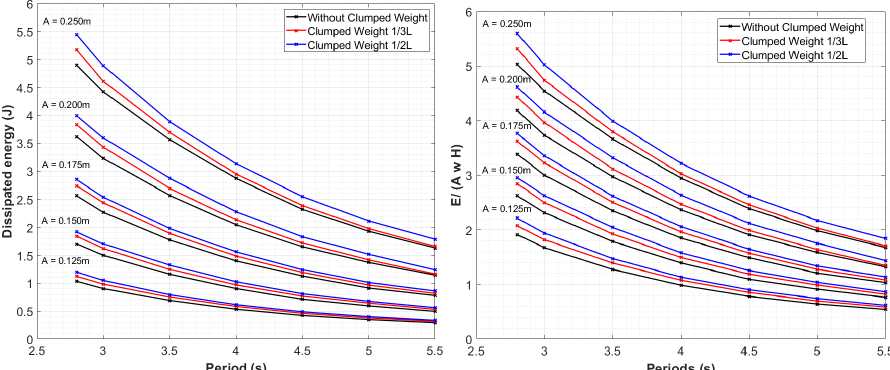
Figure 15. Dissipated energy for all the test matrix. Dimensional form ( left ) and non-dimensional form ( right ).